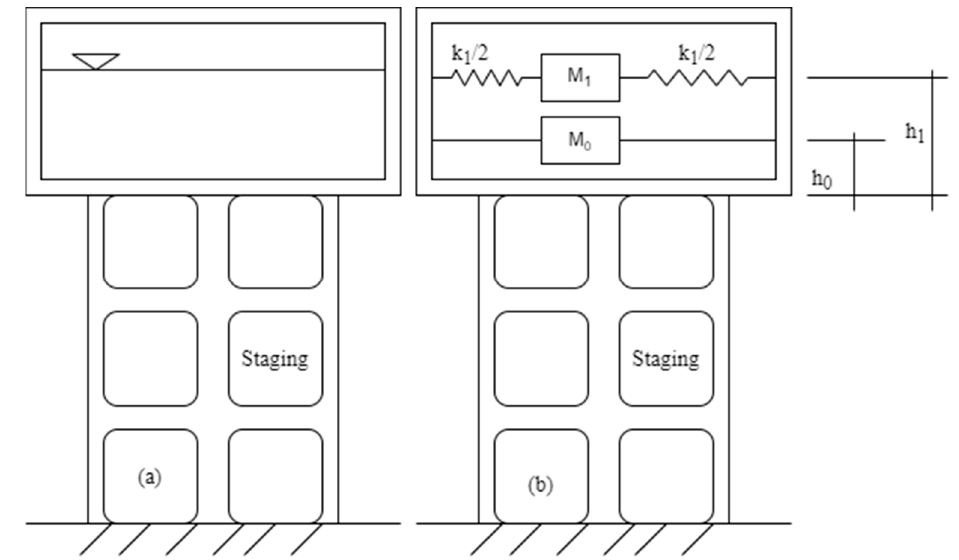
Figure 4. Spring mass model for fluid-structure interaction. Spring and joint mass were used to incorporate fluid-structure interaction in the finite element model. All the parameters of the spring mass model, including convective mass, impulsive mass, spring constant, and height of application of convective and im- pulsive mass were calculated as per the IITK-GSDMA guidelines [21]. The impulsive mass is attached to the node of shell element (wall) at a height h 0 in the u 1 direction and distrib- uted equal number of nodes (n). At the level of h 1 , n radial links each with spring constant (K 1 /n) were assigned in the u 1 direction. Then, the convective mass (M 1 /n) was applied at the center of the radial link in the u 1 direction, as shown in Figure 5. Figure 5. Spring mass model, convective mass attached to tank wall through link and impulsive mass rigidly attached to the tank wall. 2.4. Soil Flexibility The flexibility of underlying soil can affect dynamic response of structures. A previ- ous study by [22] demonstrated the importance of soil–structure interaction in a building constructed in the Kathmandu Valley. Foundation flexibility at the tank site is considered in this study by using spring elements. The structure under consideration consists of a